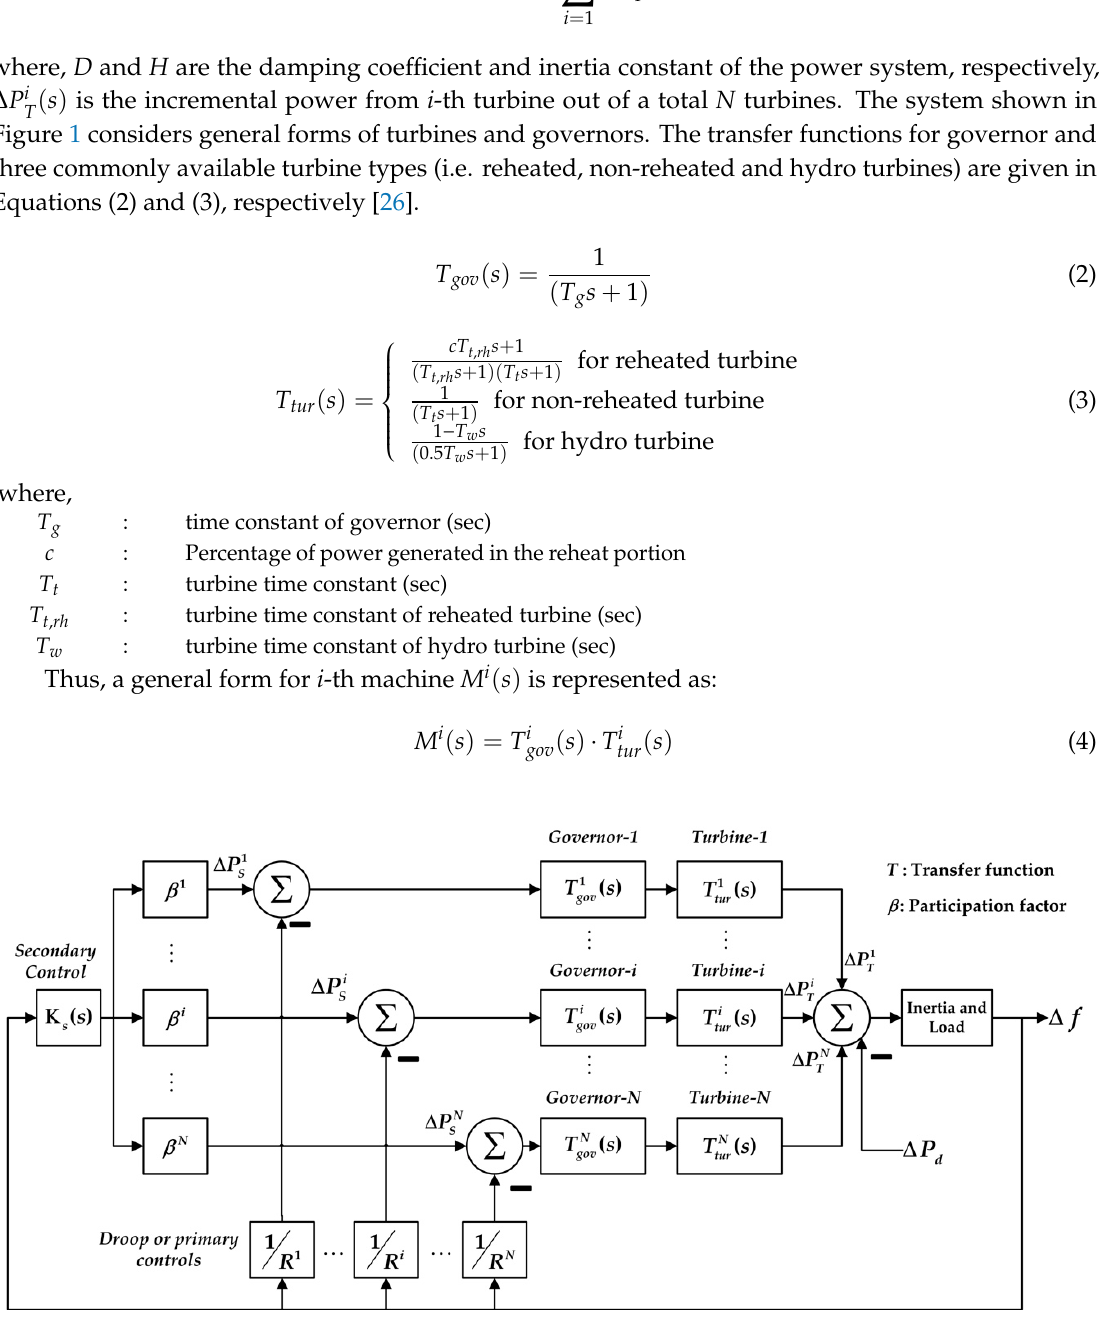
Figure 1. Model of a multi-machine power system.